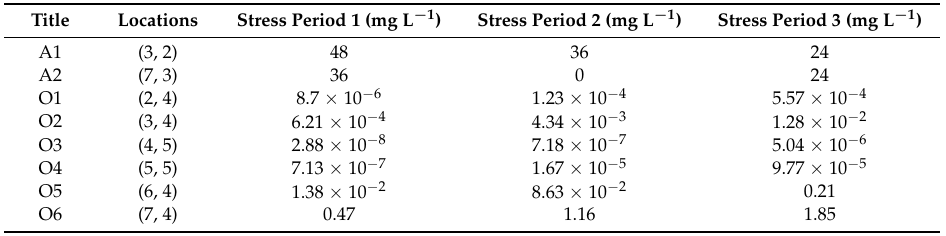
Table 9. Comparison of actual and identified characteristics when the generation number is 10. Stress Period No.